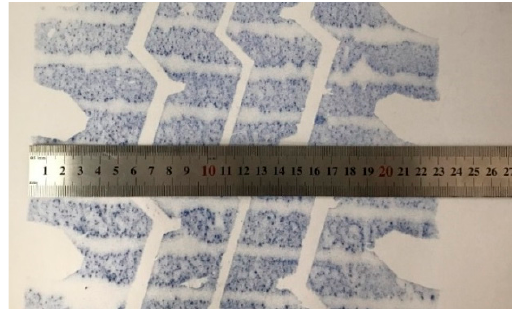
Figure 13. Measurement of wheel track.